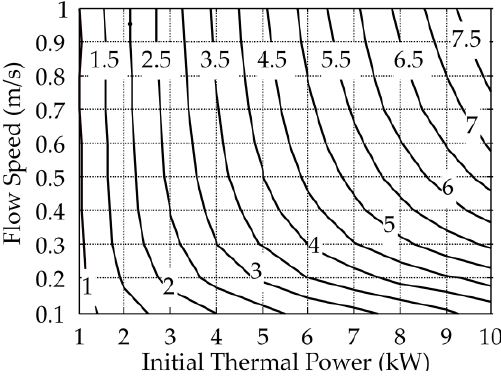
Figure 17. Actual thermal power curves.